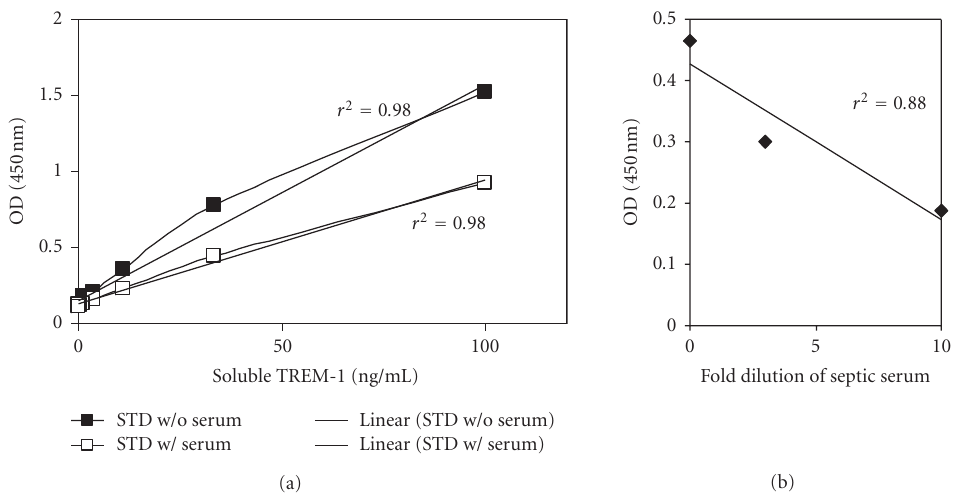
Figure 1: ELISA for sTREM-1. (a) Titration of recombinant human TREM-1::IgG1 either in the absence (filled symbols) or presence of normal human serum (open symbols). (b) Serial dilution of serum from a septic patient. The r 2 values are the correlation coe ffi cients of the depicted data.